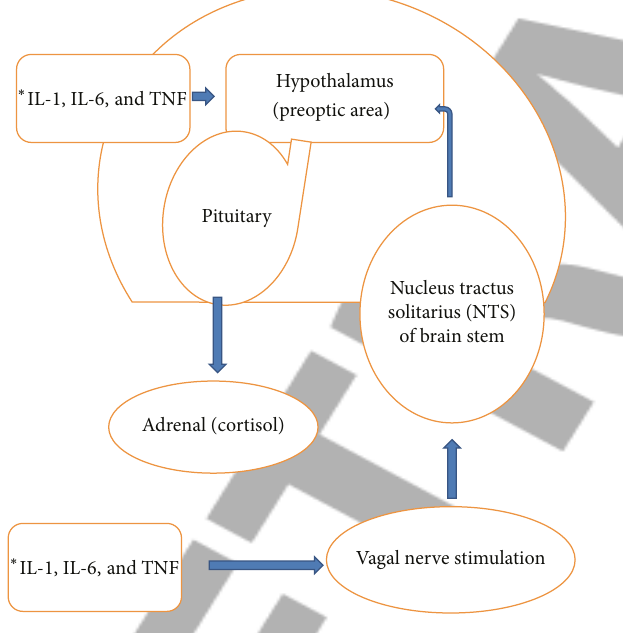
Figure 2: Vagal nerve stimulation and effect on hypothalamus- pituitary-adrenal axis; peripheral cytokines after crossing the blood brain barrier (BBB) also directly affect hypothalamus-pituitary- adrenal axis.